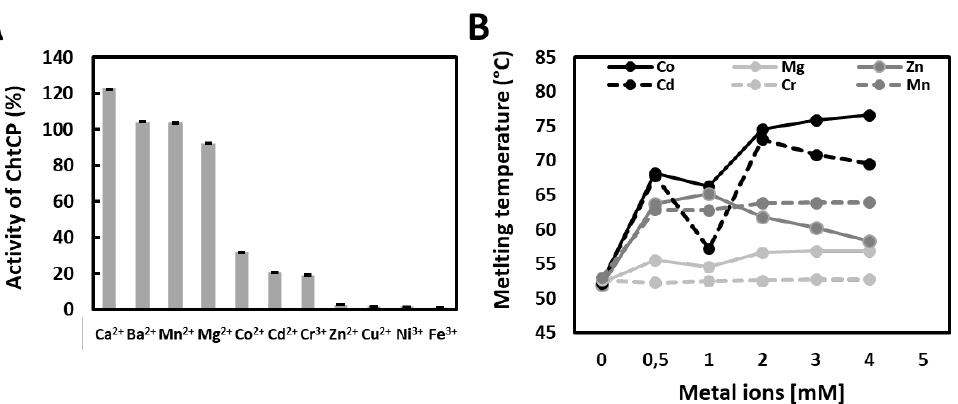
Figure 3. The effect of metal ions on ChtCP activity and melting temperature. ( A ): Effect of metal ions on ChtCP activity. The values were normalized to a control where no metal ions were added. ( B ): Melting temperature of ChtCP in the presence and absence of metal ions (Co 2+ , Cd 2+ , Mn 2+ , Mg +2 , Cr 3+ and Zn 2+ ). 0.5 mM to 5 mM of CoCl 2, CdCl 2 , MnSO 4 , MgSO 4 , CrSO 4 and ZnCl 2 ) were added to 4 µ g of purified ChtCP in hepes pH 8.0. The Tm was determined via thermal shift assay, being the released fluorescence of Sypro orange ( λ excitation = 410 nm, λ emission = 610 nm) measured by qPCR Stratagene Mx 3000P (Agilent, Santa Clara, CA, USA) system in a ramp of temperature, from 50 °C to 80 °C.